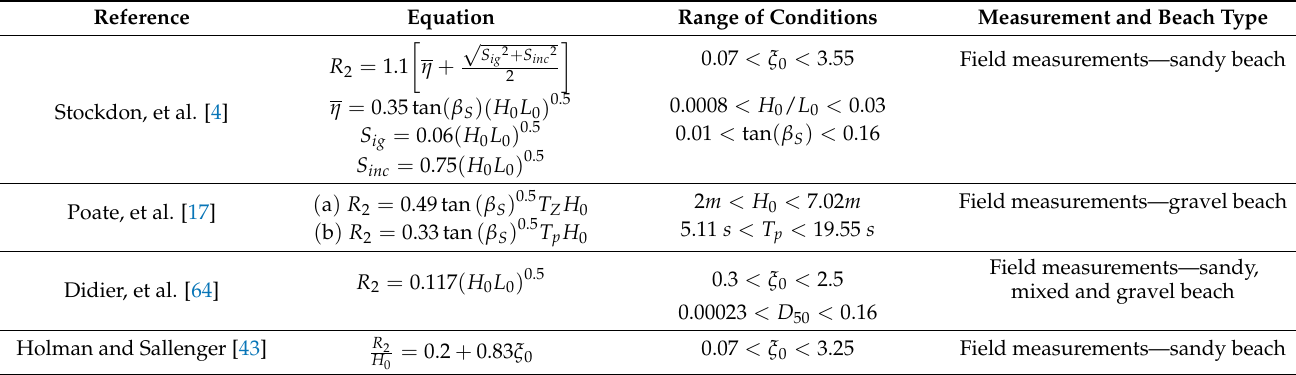
Table A2. Table of relevant and well-known empirical wave runup equations tested on beach Ploˇce; associated range of conditions, beach, and measurement type are shown for each derived